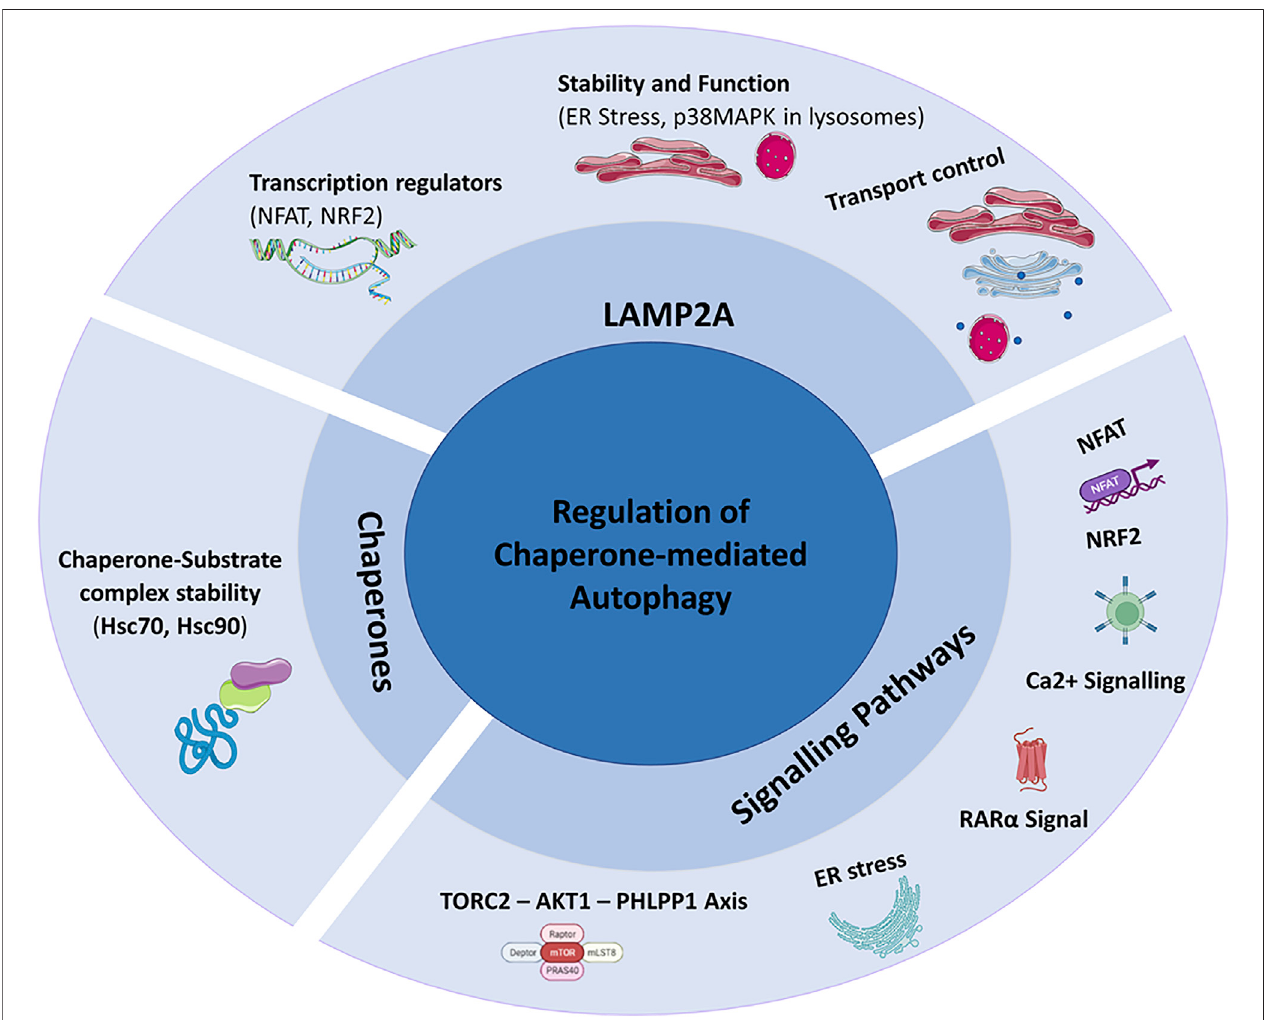
FIGURE 3 | Regulation of Chaperone-Mediated Autophagy (CMA): CMA is mainly regulated by LAMP2A, chaperones and signalling pathways.